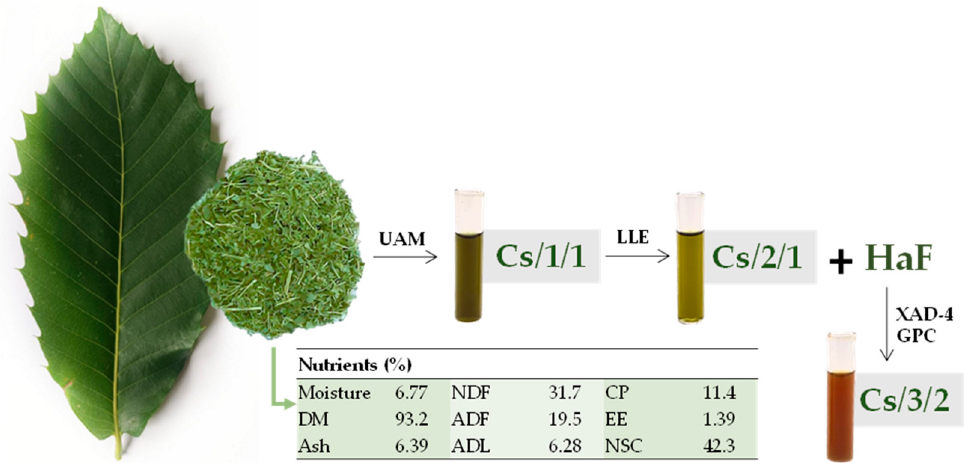
Figure 1. Castanea sativa Mill. leaf chemical composition parameters expressed as % of DM, and fractionation scheme to achieve bioactive fractions. DM: dry matter; NDF: neutral detergent fiber; ADF: acid detergent fiber; ADL: acid detergent lignin; CP: crude protein; EE: ether extract; NSC: no structural carbohydrates; UAM: ultrasound assisted maceration; LLE: liquid–liquid extraction; HaF: hydroalcoholic fraction; XAD-4 GPC: gel permeation chromatography on Amberlite XAD-4 absorbent resin.